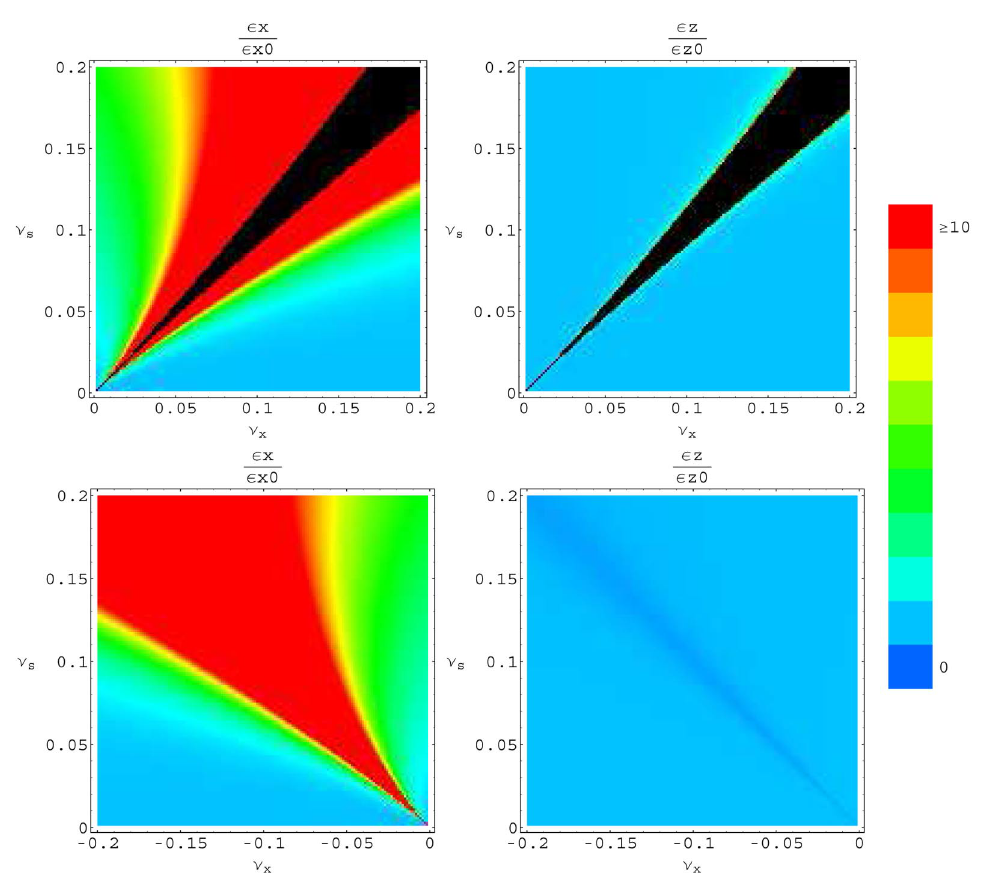
FIG. 3. (Color) Projected emittances near the sum and difference resonances due to dispersion at the rf cavity. The parameters are the same as those in Figs. 1. The upper two plots are for the sum resonance with (cid:2) (cid:8) two plots are for the difference resonance with (cid:2) (cid:1)